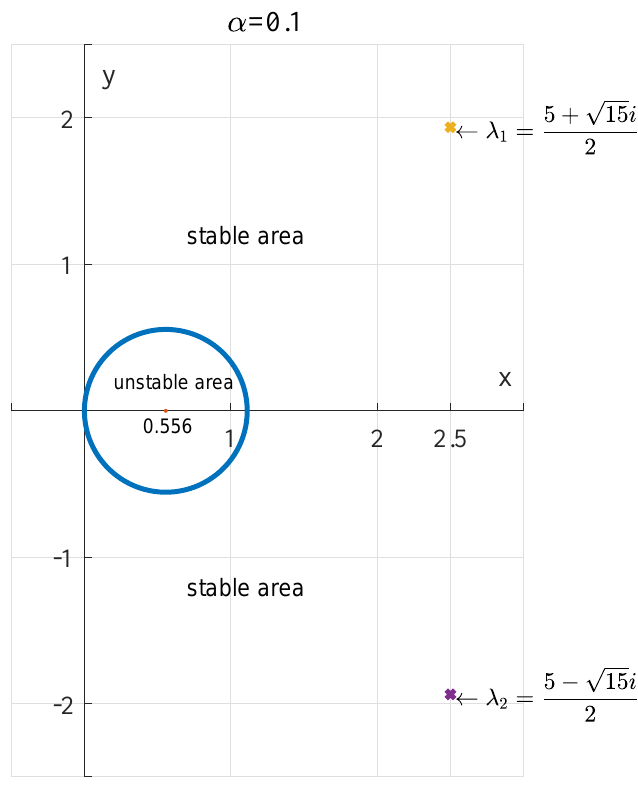
Figure 4. When α = 0.1, system (14) is stable.